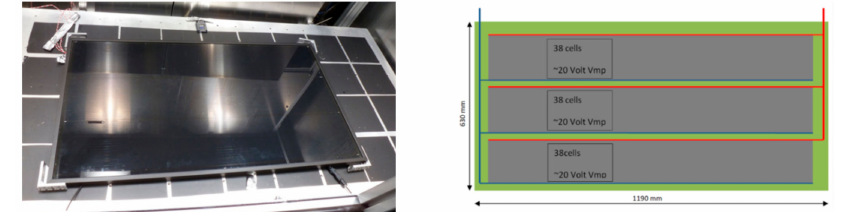
Figure 4. PV panel in the sun simulator at the Forschungszentrum, Jülich ( left ); configuration of the PV cells in the Solibro CIGS module ( right